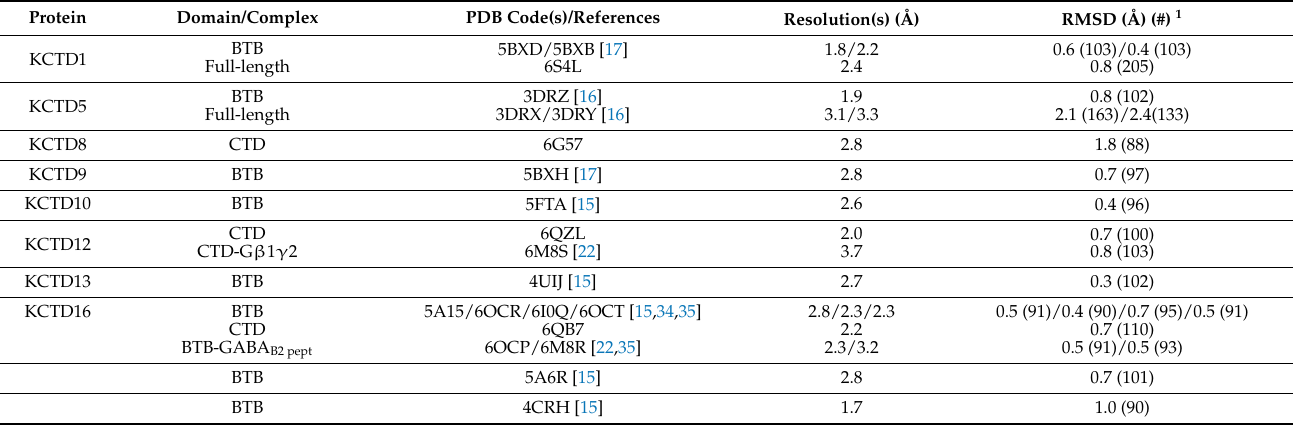
Table 1. Structures of KCTD proteins in the PDB and their similarity with the corresponding AlphaFold models. If multiple crystal structures of the same protein/domain were present, the one determined at the highest resolution was used for calculation of RMSD